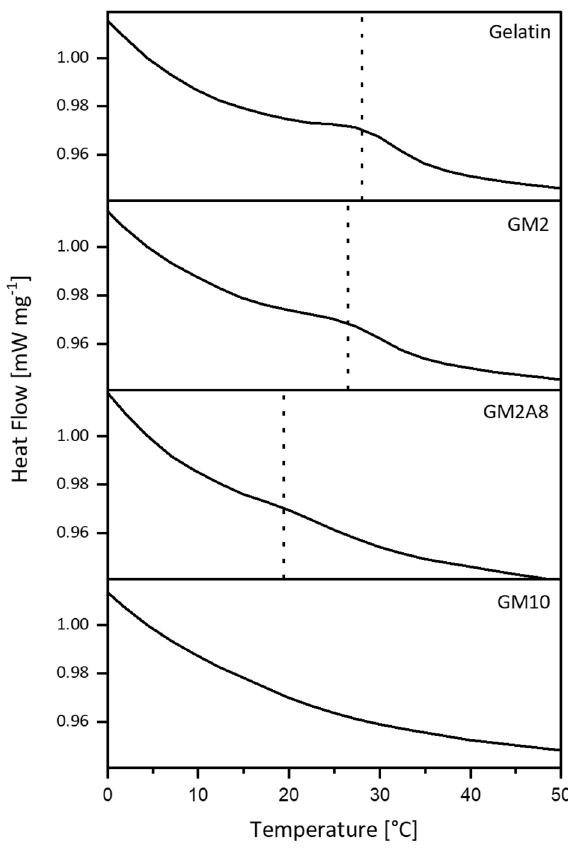
Figure 2. Differential scanning calorimetry (DSC) curves of unmodified gelatin, GM2, GM2A8, and GM10. Vertical dotted lines indicate the melting temperatures. The figure was created with Origin 2019b (https ://www. origi nlab.com/2019b